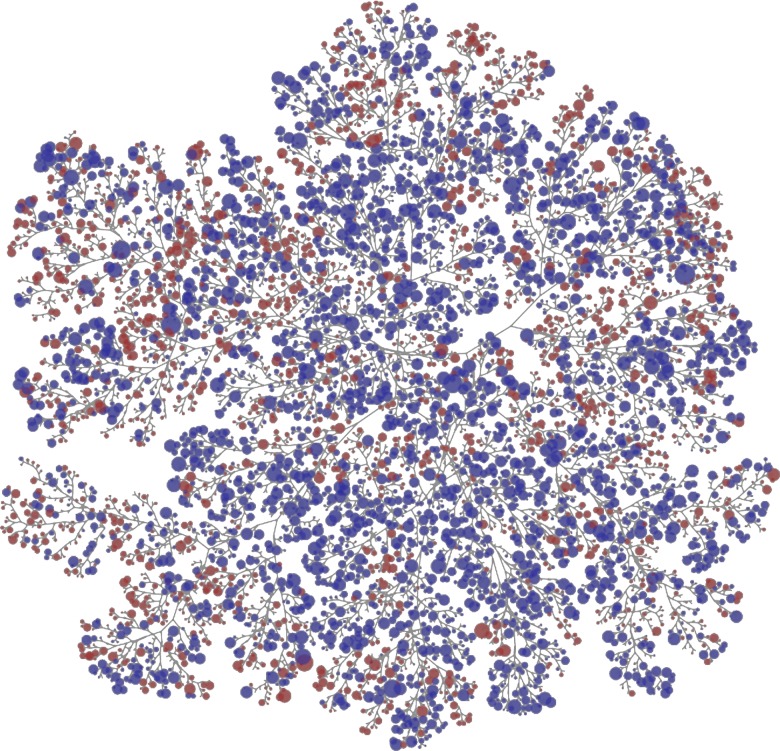
ChemTreeMap [39] of the allosteric (blue) and competitive (red) ligands is a hierarchical tree based on grouping ligands by the Tc of the ECFP6 fingerprints.The size of each circle represents the number of ligands in a cluster of Tc ≥ 0.6. Though a few small regions of chemical space are dominated by one set or the other, the large number of branches with interdigitated red and blue circles shows that there is a great deal of chemical similarity between the allosteric and competitive ligands. To quantify the overlap, we should note that 623 out of 70,219 allosteric ligands (1%) are within Tc ≥ 0.6 of a competitive ligand, and 582 of the 9511 competitive ligands (6%) are within Tc ≥ 0.6 of an allosteric compound.